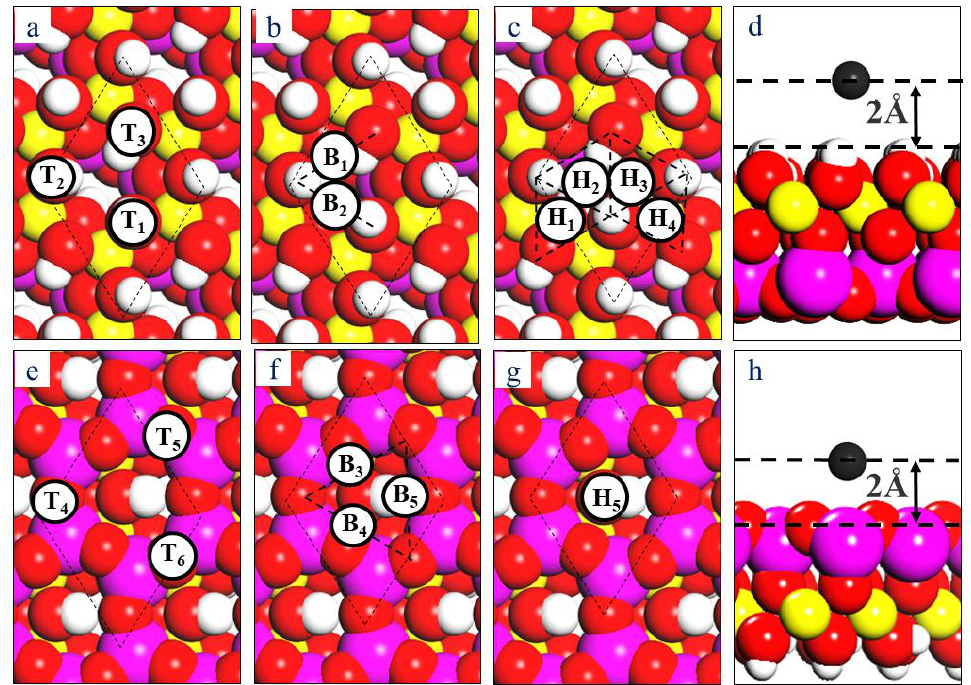
Figure 1. ( a – c ) Top view of kaolinite (001) surface with three top adsorption sites (T 1 –T 3 ), two bridge adsorption sites (B 1 –B 2 ), and four hollow adsorption sites (H 1 –H 4 ). Top view of kaolinite (001̄) surface with ( e ) three top adsorption sites (T 4 –T 6 ), ( f ) three bridge adsorption sites (B 4 –B 5 ), and ( g ) one hollow adsorption site (H 5 ). Side view of the initial relative position model between Y (Nd or La) and kaolinite (001) surface ( d ) and ( 001 surface ( h ) before adsorption. Here, white spheres, red spheres, yellow spheres, purple spheres, and dim grey spheres represent hydrogen, oxygen, aluminum, and silicon, Y (Nd or La) atom,